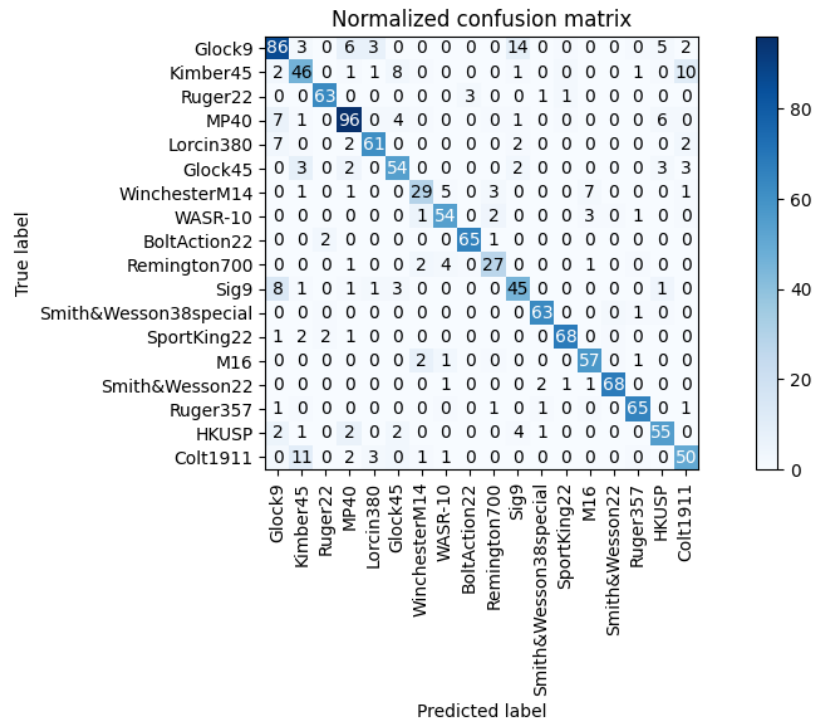
Figure 11. Comparison of transfer learning and knowledge distillation data.